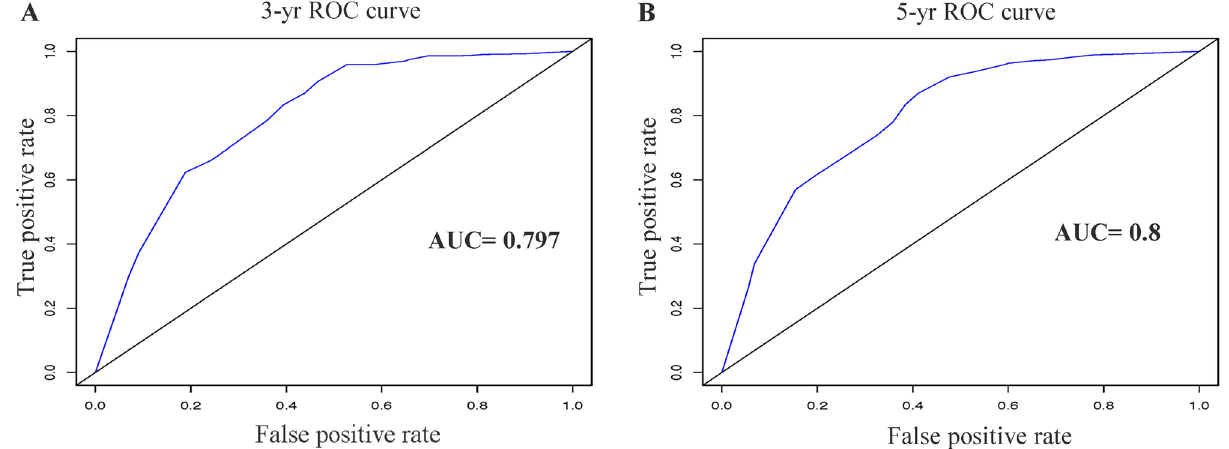
Figure 5. Time-dependent receiver operating characteristic curve analysis for the sensitivity and specificity of the nomograms. Receiver operating characteristic of the nomogram for ( A ) 3-yr survival and ( B ) 5-yr